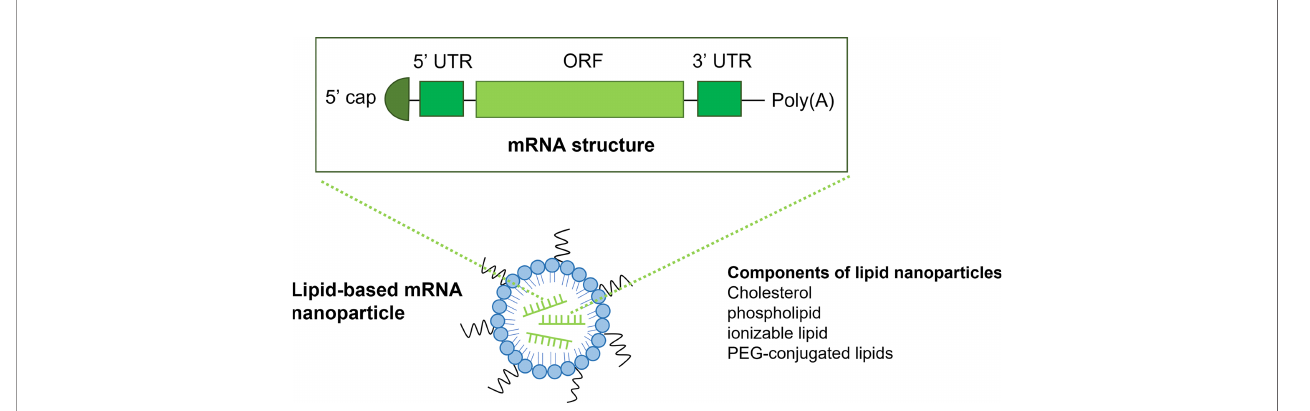
FIGURE 1 | The structure of mRNA and lipid-based nanoparticles. The structure of mRNA (top) consists of a 5 ’ cap, a 5 ’ UTR and a 3 ’ UTR, an open reading frame and a poly(A) tail. Lipid nanoparticles (LNPs) are the most commonly used vectors for the delivery of mRNA vaccines. LNPs often comprise of ionizable lipid, Cholesterol, phospholipid and